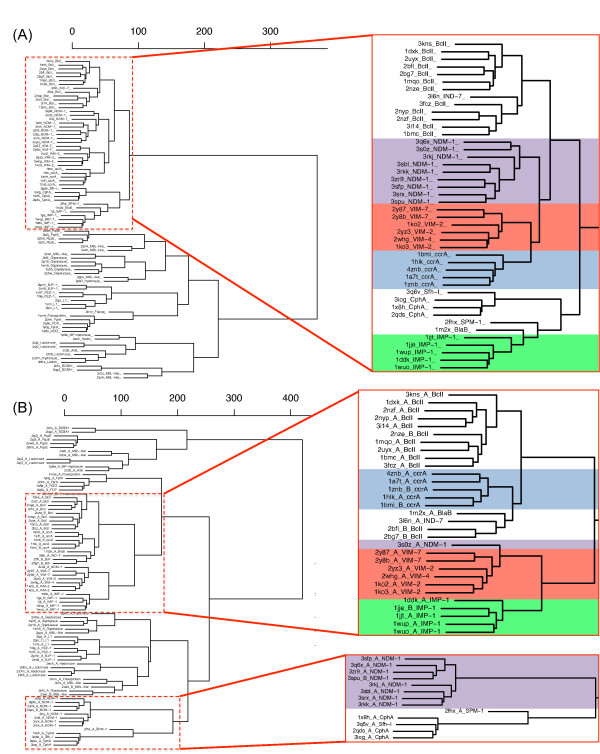
StralCP dendrograms and clusters for MBL-like proteins. Structure-based similarity dendrograms based on substructures of the (A) active site, and (B) linker region, constructed using pairwise average-link Euclidean distances. The subtrees are magnified sections of the dendrograms corresponding to the main branch containing the B1 MBL clusters, as determined via StralCP, where coloring correspond to VIM-type (red), IMP-type (green), NDM-1 (purple) and ccrA (blue) structures.